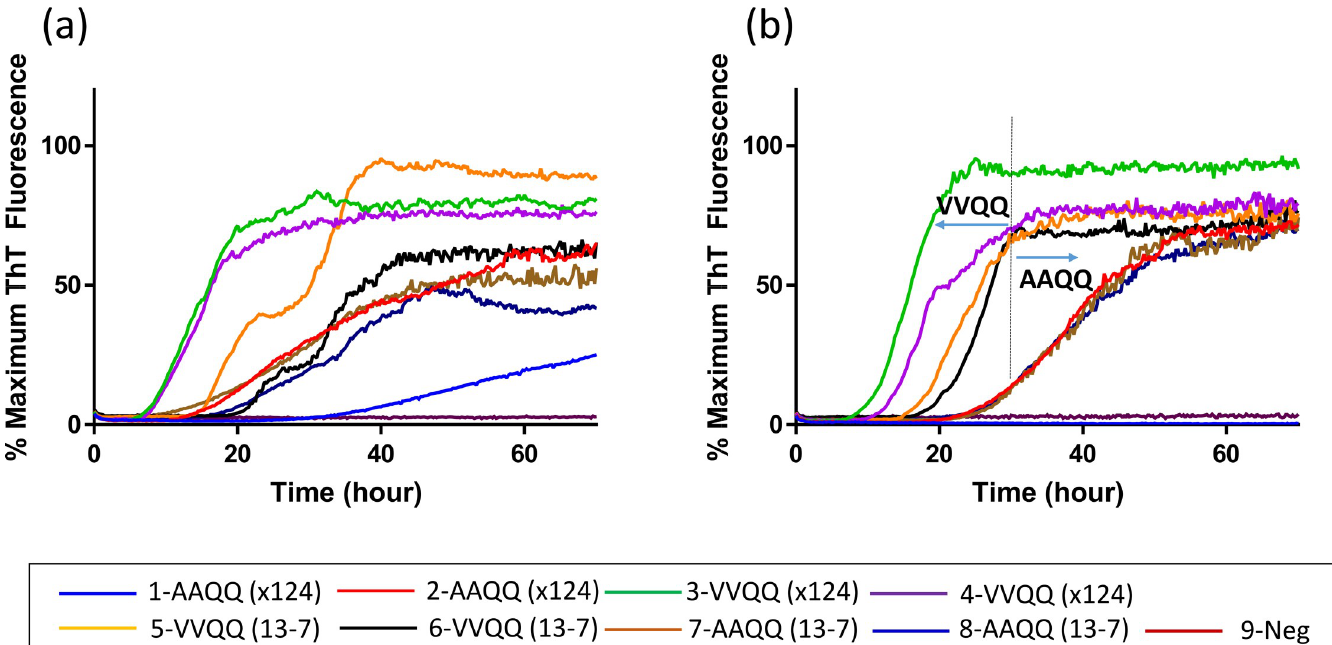
Fig 6. RT-QuIC detection of seeding activity of scrapie prions from sheep brain samples using mature elk prion protein 132L (a) and 132M (b) (23–231). RT-QuIC reaction mixtures were seeded with 10 − 2 of EIA normalized brain tissues from uninfected, x124 infected sheep. A final 400 mM NaCl was used with the substrates. Data are presented as mean ThT fluorescence of 4 technical replicates.